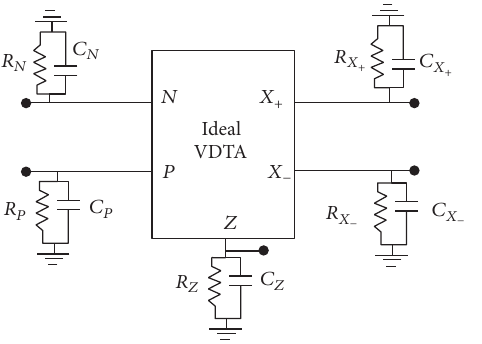
Figure 4: Nonideal model of VDTA.